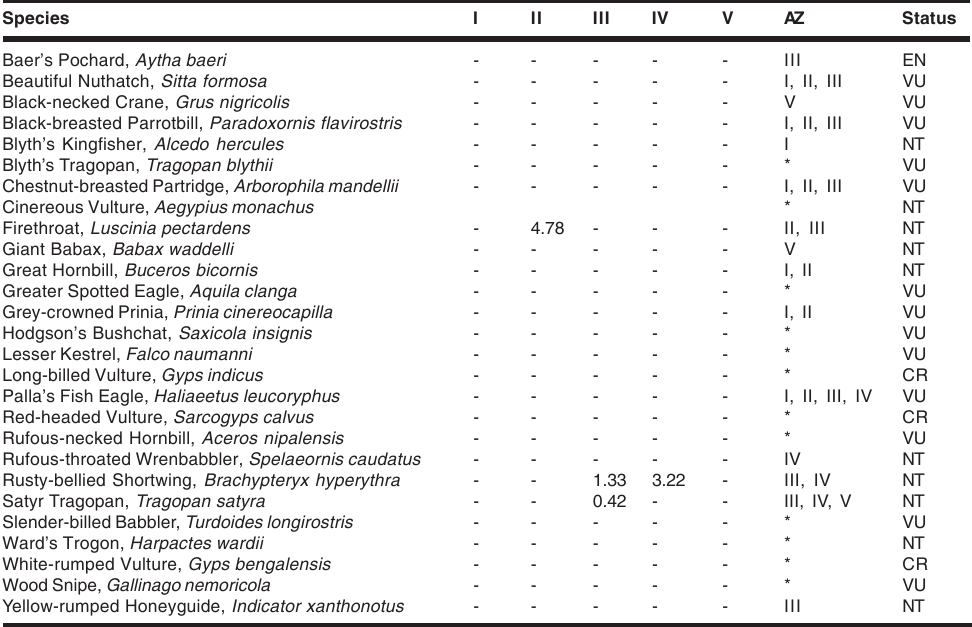
Table 2. Threatened birds of Sikkim (IUCN 2009). Numbers indicate density (numbers/ha) of birds observed during the study in different elevation zones {I (<900m), II (900-1800m), III (1800-2800m), IV (2800-3800m) and V (3800-4500m and above)} in Sikkim. Species